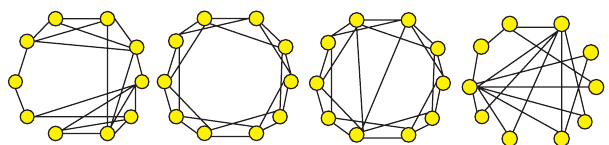
Figure 1: Different complex network topologies: random network, grid network, small world network, and scale free